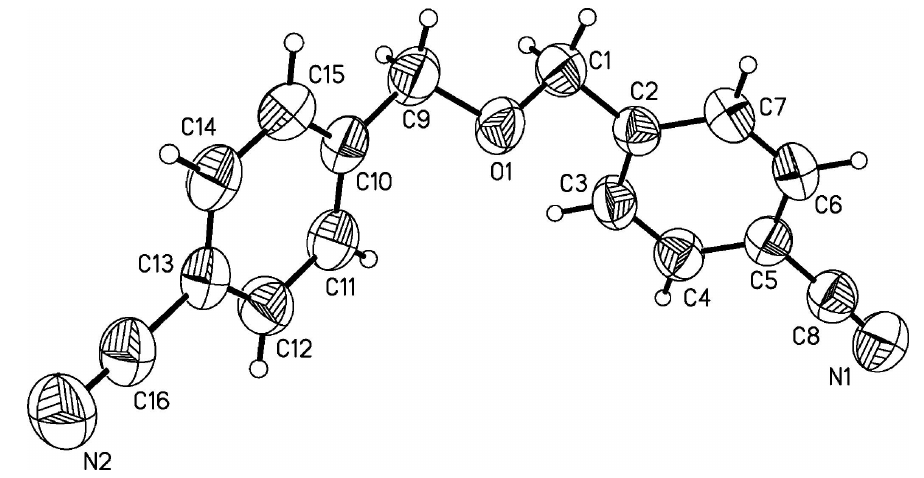
Figure 1 The molecular structure of the title compound, showing the atomic numbering scheme. Displacement ellipsoids are drawn at the 50% probability